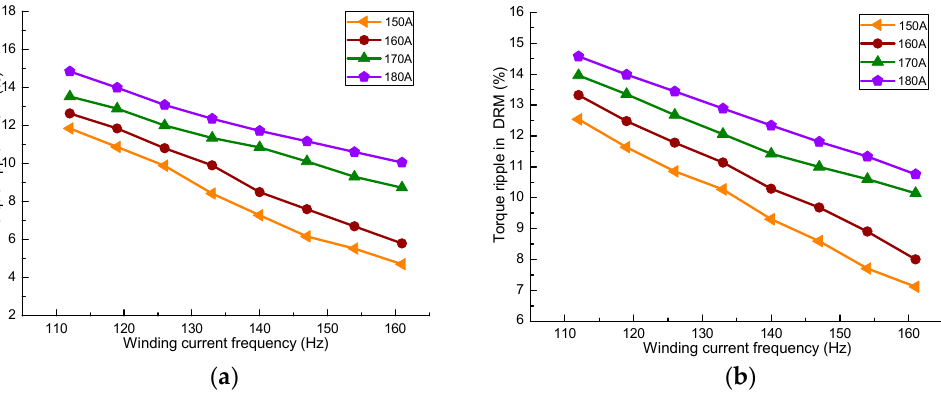
Figure 7. Variation of torque ripple in SM and DRM with winding current frequency: ( a ) SM; ( b ) DRM.